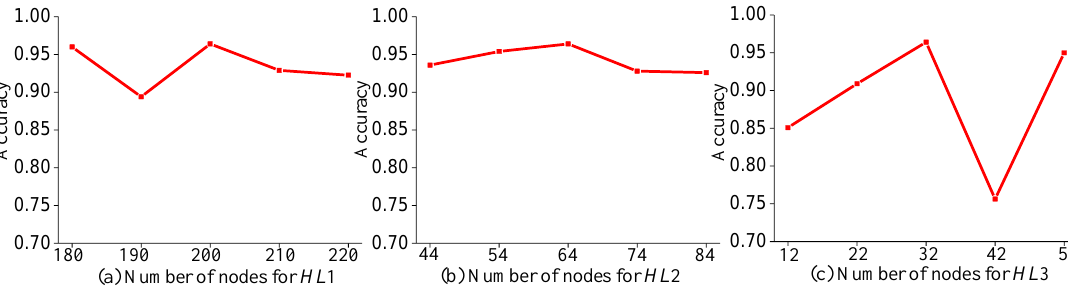
Figure 15. The performance of ANN-BP with varied of node numbers in the hidden layers.